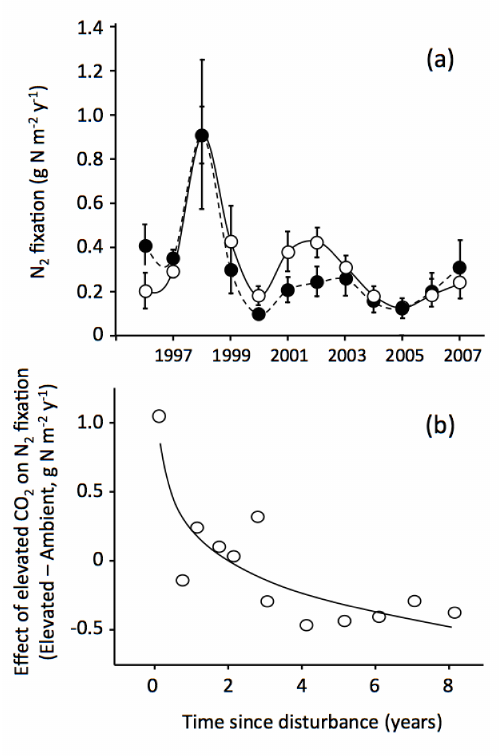
Figure 1. Rate of N 2 fixation (a) and effect of elevated CO 2 on N 2 fixation as a function of time since disturbance (b) for Galactia el- liottii during 11years of experimental exposure to increased carbon dioxide concentrations. For panel (a) Values are means ± standard error of the mean ( n = 8) for the ambient (open circles) and elevated (filled circles) CO 2 treatments. For panel (b) , values are differences of means for each year of the experiment.